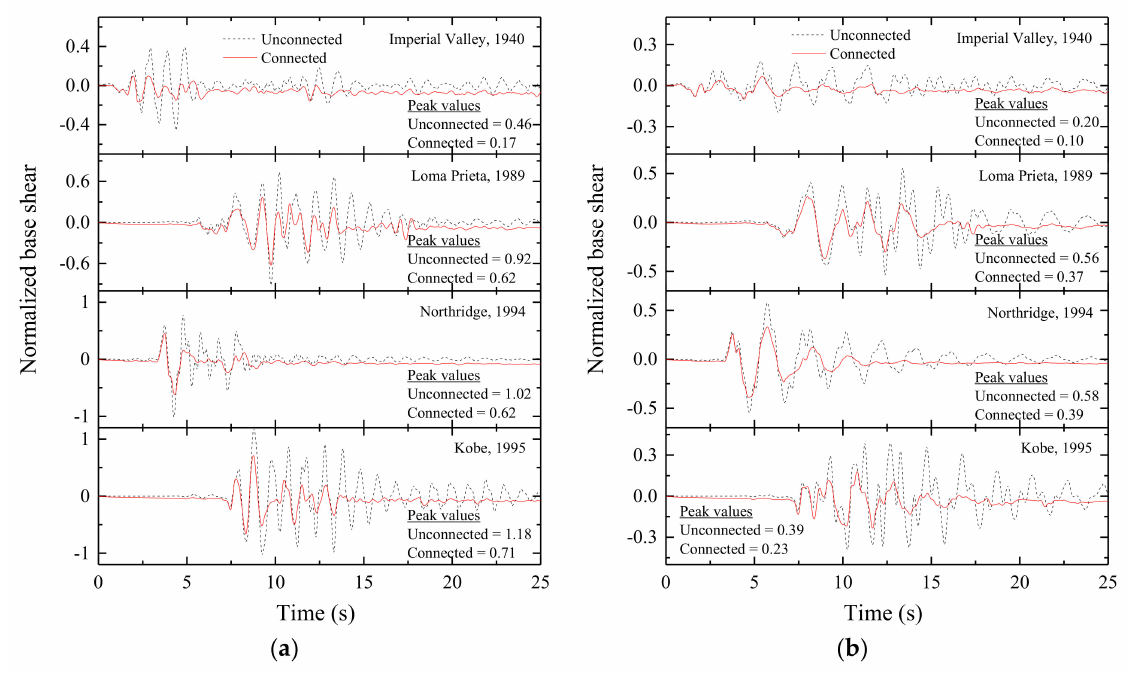
Figure 10. Time history of normalized base shear in: ( a ) a coupled stiff building and ( b ) a coupled flexible building when semi-active MR dampers are used as coupling devices in Configuration 1.